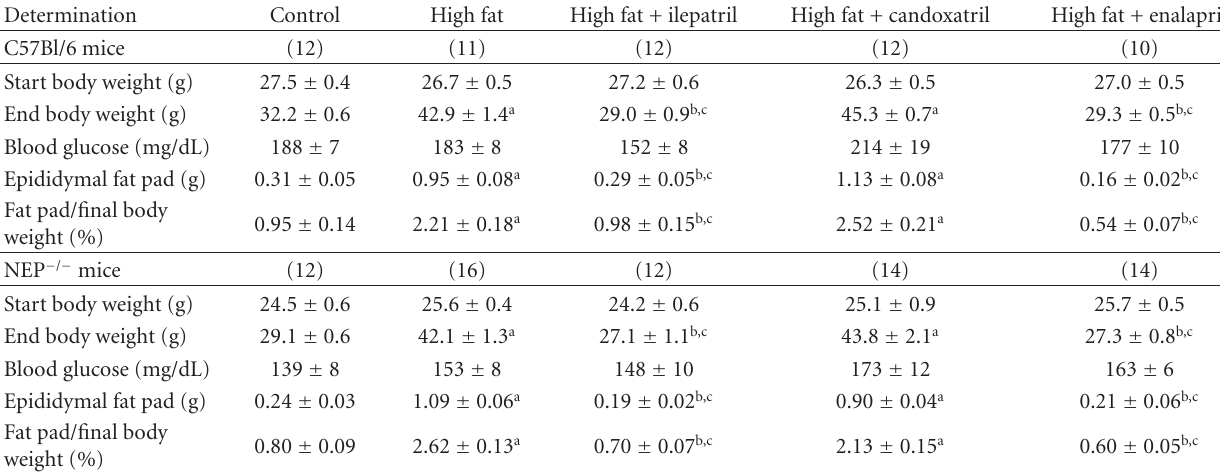
Table 1: Prevention study in C57Bl/6 and NEP − / − mice. E ff ect of high fat diet +/ − ilepatril, candoxatril, or enalapril on change in body weight, blood glucose, and epididymal fat